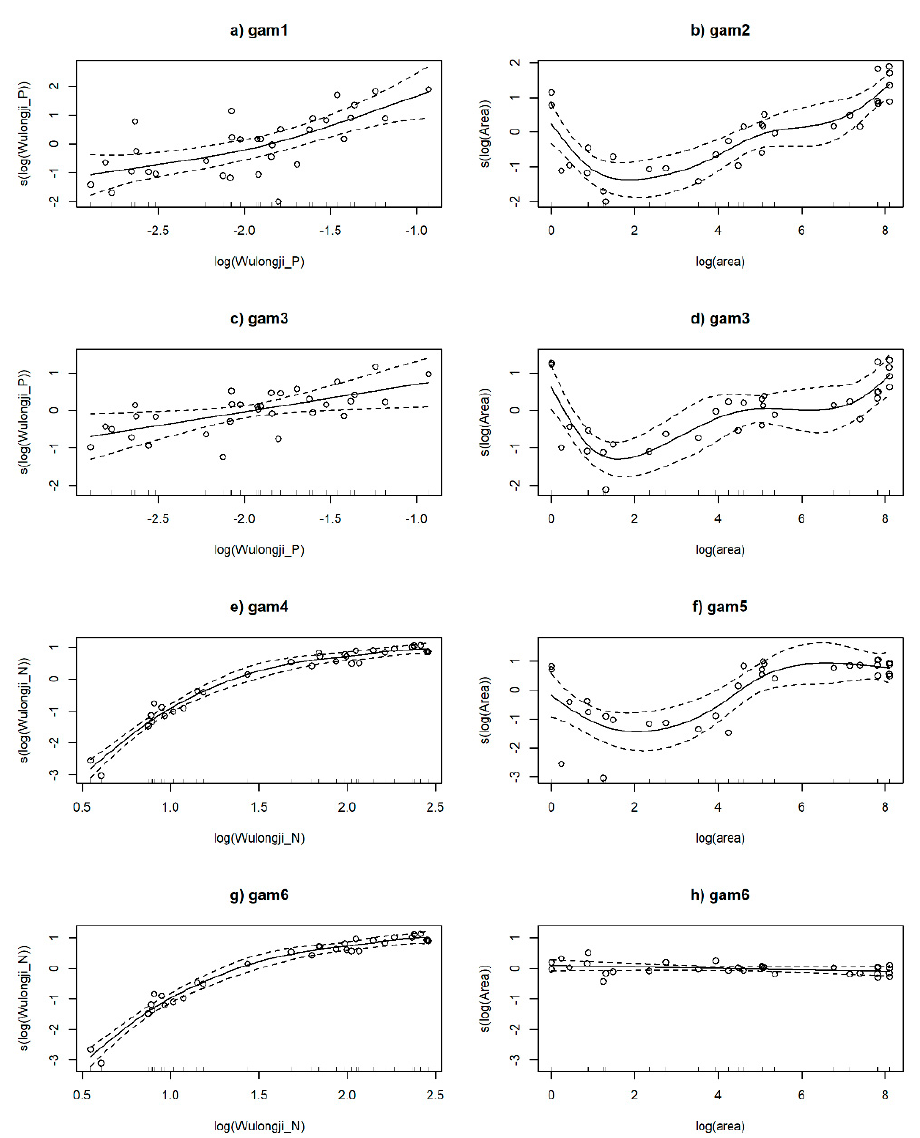
Figure 5. GAM panel plots: the effect of each smooth function at logarithmic scale.